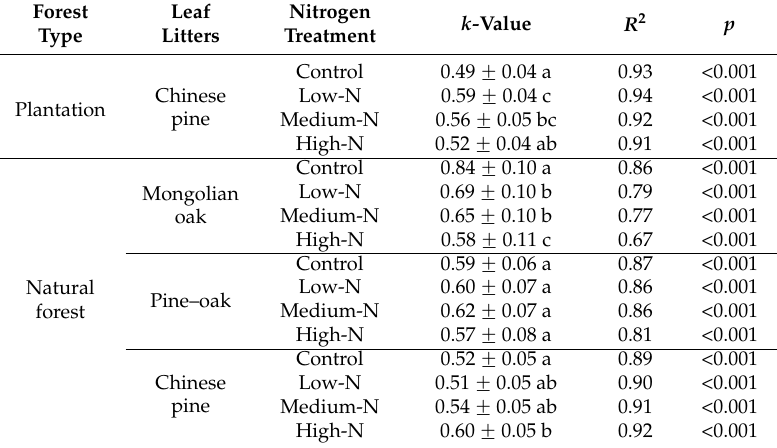
( X t / X 0 = e ´ kt ) and correlation coefficient ( R 2 ) for single-species litter and litter mixture under the